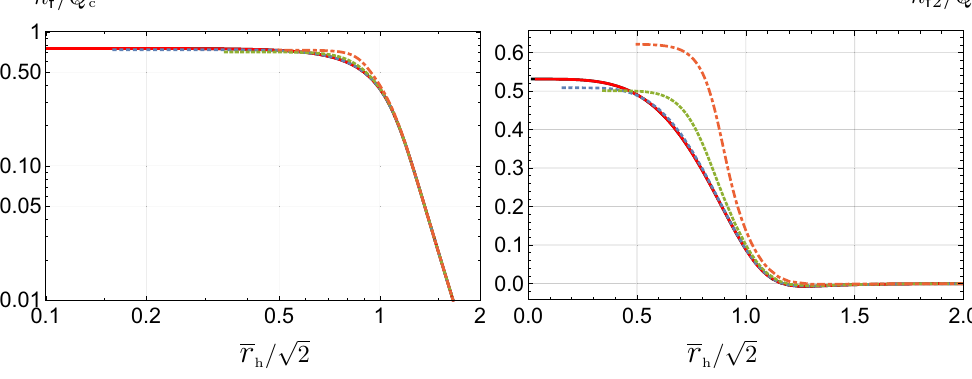
Figure 10 . UV coefficients κ